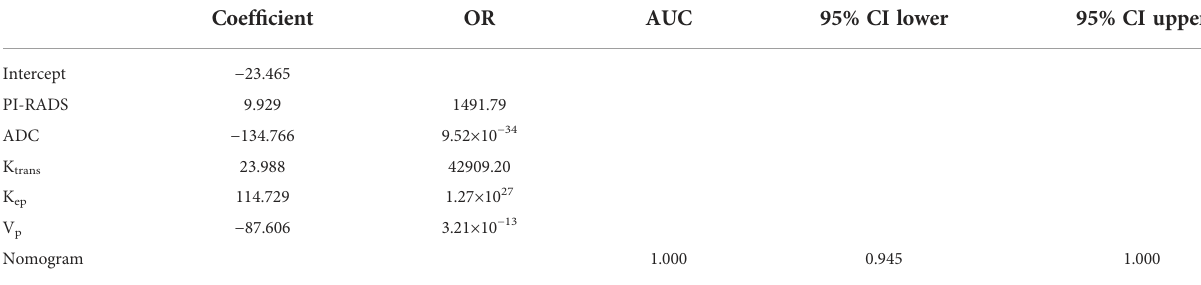
TABLE 4 Diagnostic performance of DCE-MRI parameters, ADC, and the combined